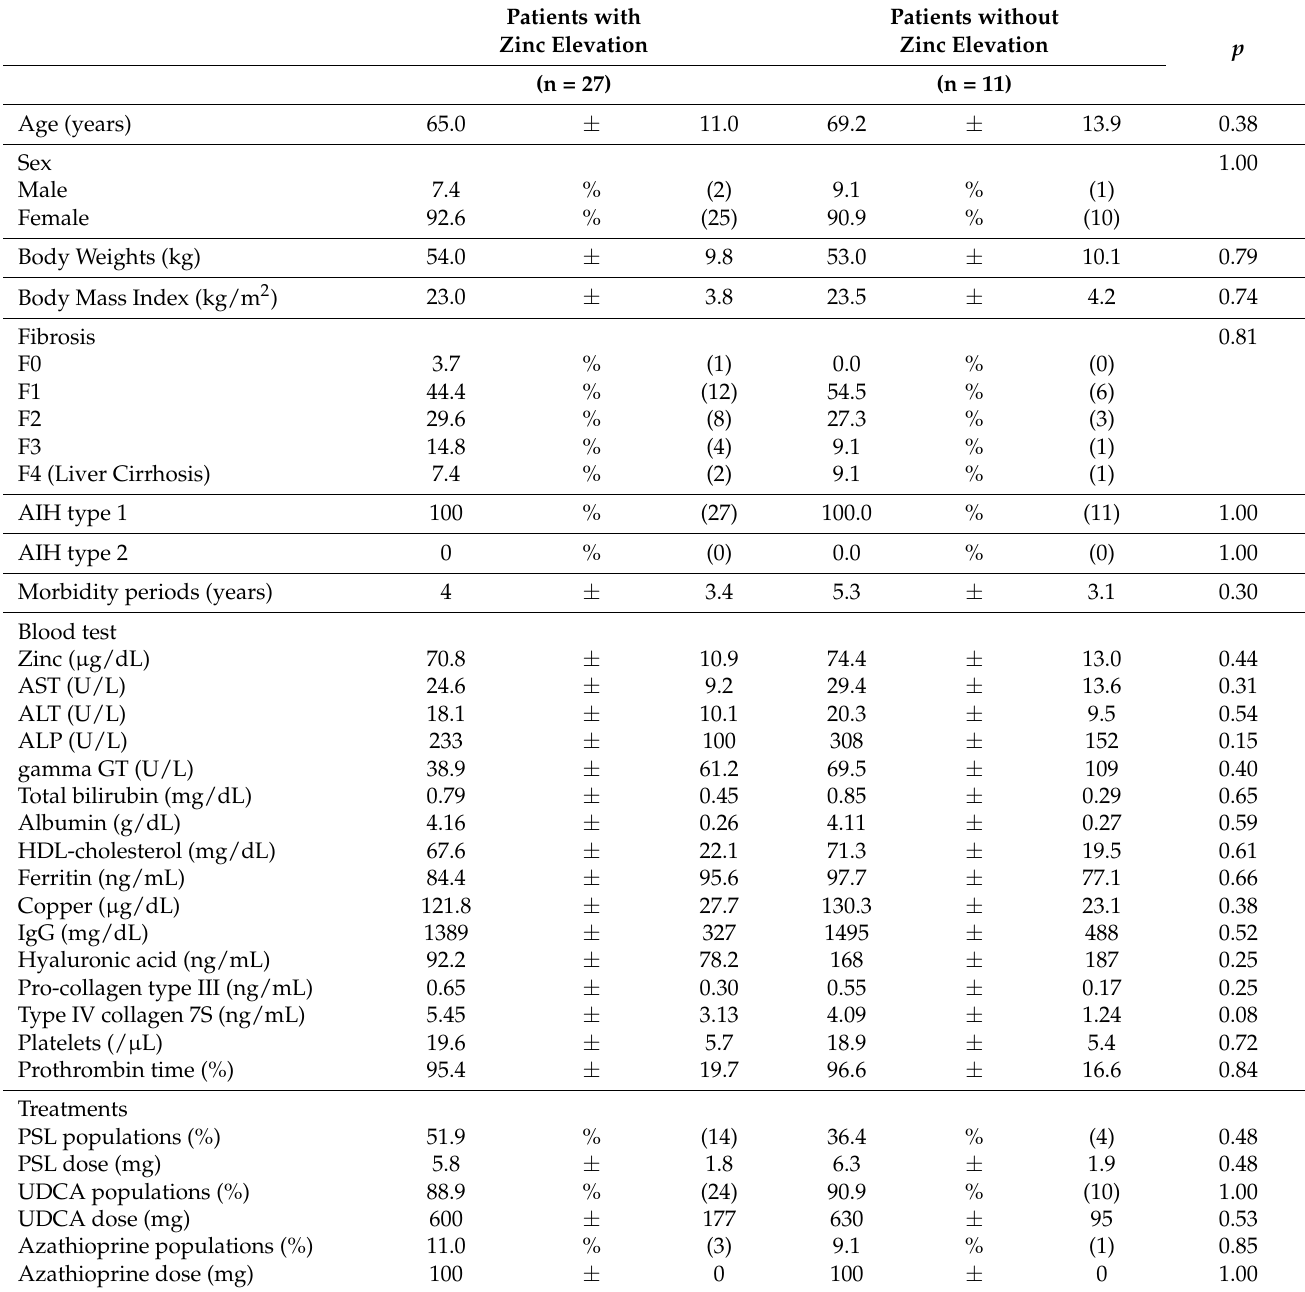
Table 1. Clinical profiles of patients with autoimmune hepatitis before zinc supplementation. Patients